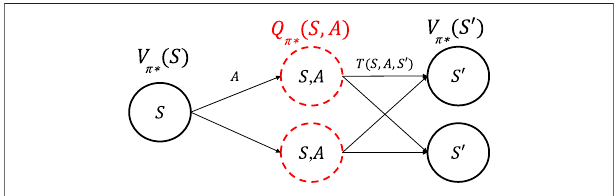
FIGURE 4 | An illustration of a single step of the value iteration process for state S that tests the Q-function for all state – action pairs, where future states follow the optimal policy π